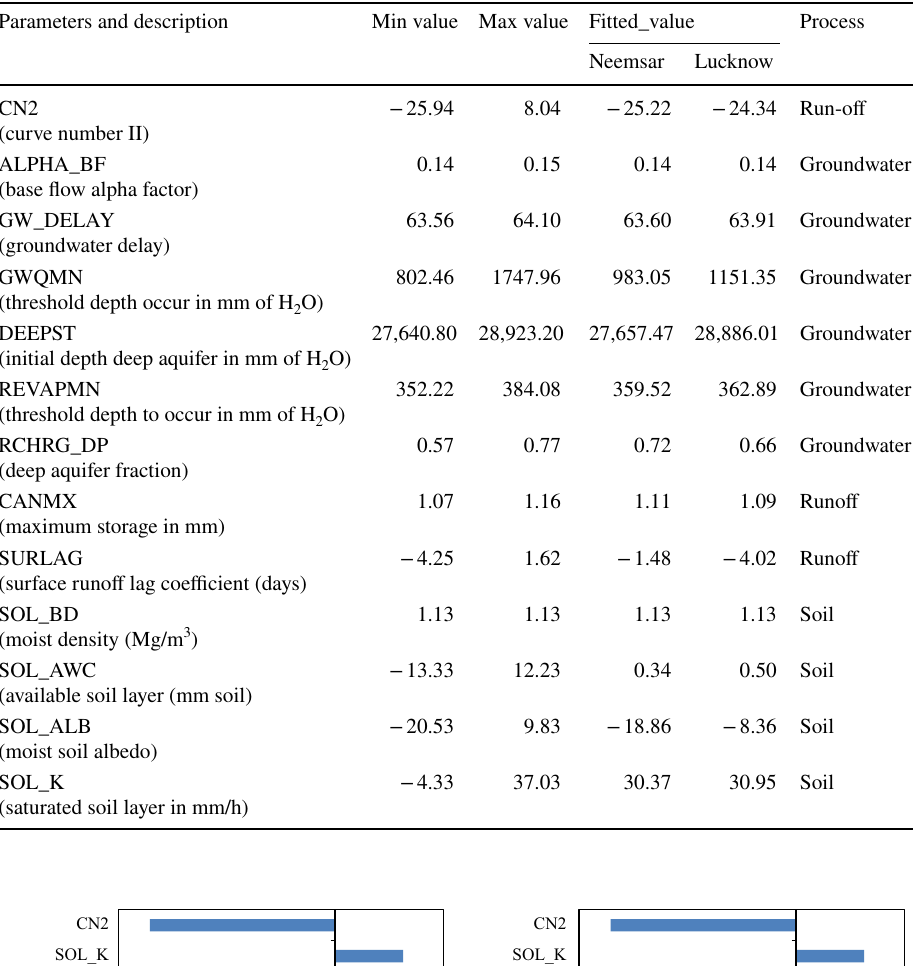
Fig. 6 a Sensitivity of hydro- logical parameters at